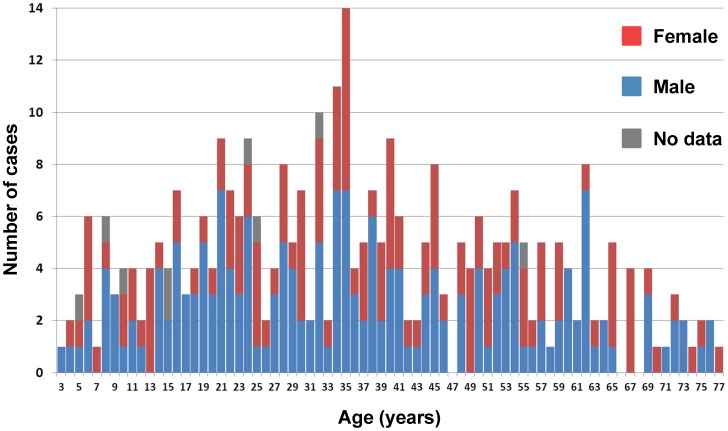
Age distribution of spinal CE (data on 325 cases).